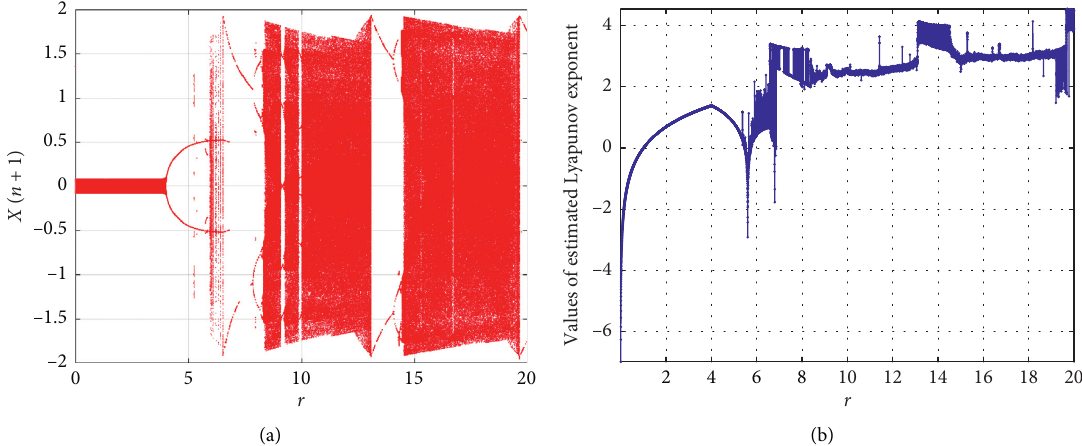
Figure 7: The bifurcation diagram (a) and Lyapunov exponent (b) for the third proposed map, at x